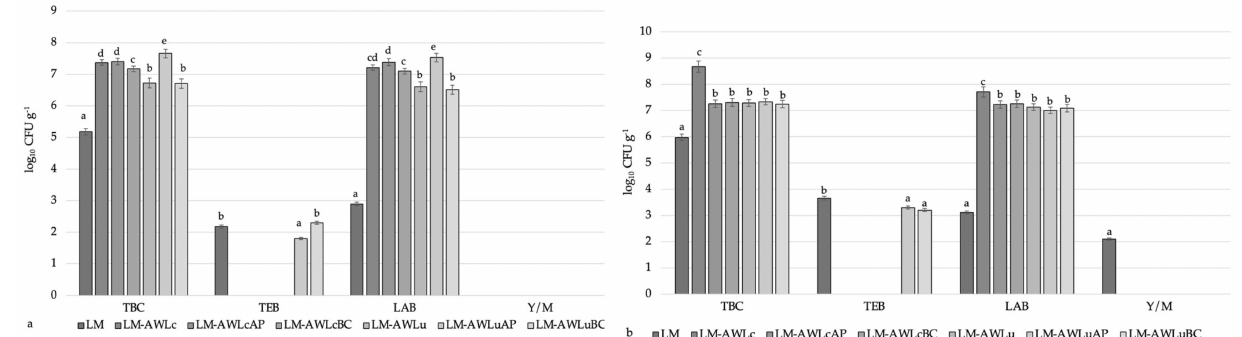
Figure 1. The influence of the different treatments on the microbial parameters of the LM after ( a ) 24 h and ( b ) 48 h. a − e Mean values with different superscript letters between columns are significantly different ( p ≤ 0.05); data are expressed as the mean values ( n = 3) ± standard error (SE); C, control; LM, lamb meat; AW, acid whey; Lc, Lacticaseibacillus casei ; Lu, Liquorilactobacillus uvarum; AP, freeze-dried apple pomace; BC, freeze-dried blackcurrant